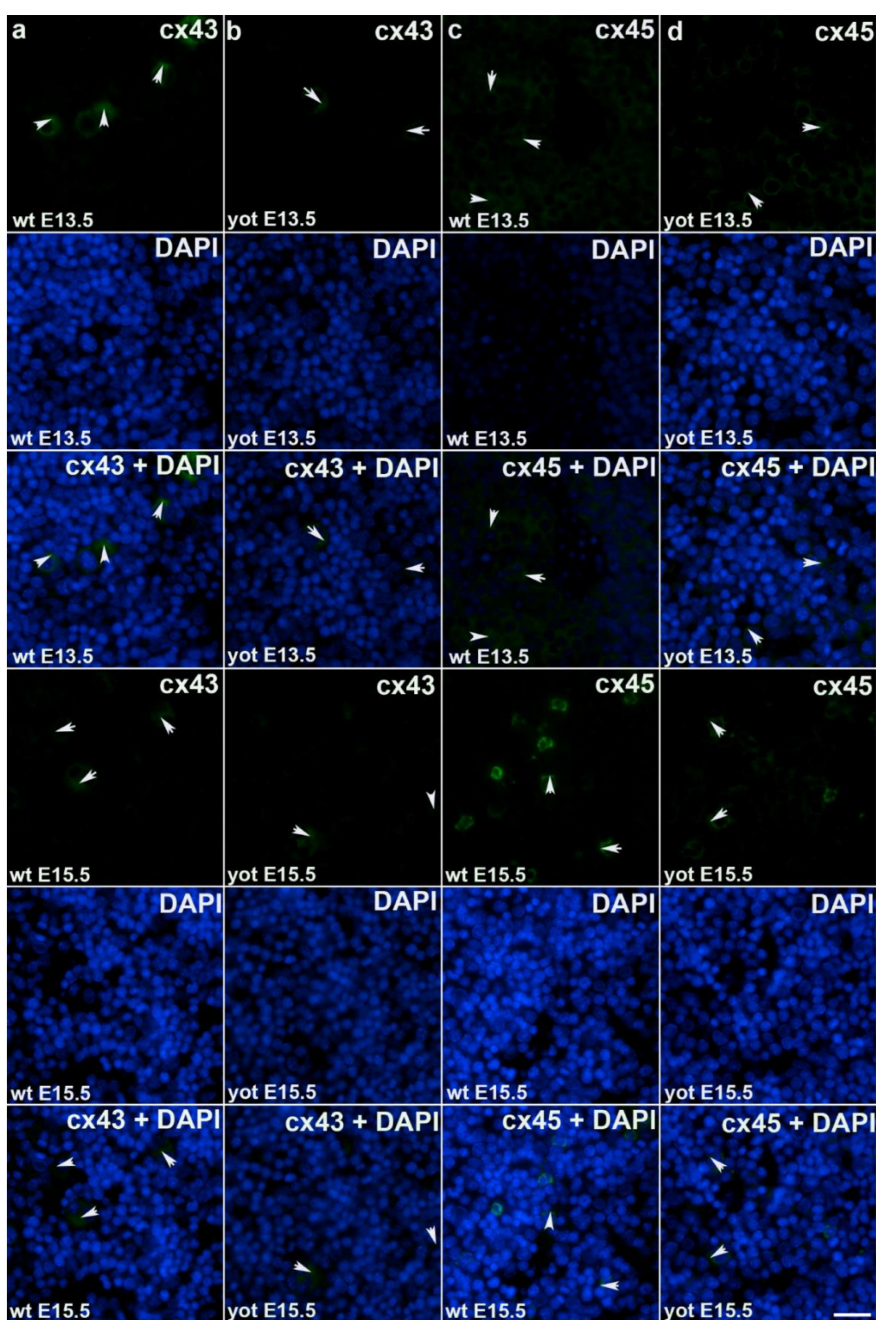
Figure 4. Immunofluorescence staining of connexins (Cxs): Cx43 and Cx45 in wild type and yotari mouse liver at gestation days E13.5 and E15.5. Immunoexpression of Cx43, 4 (cid:48) ,6-diamidino-2– phenylindole dihydrochloride (DAPI) staining and merged Cx43 and DAPI at E13.5 and E15.5 in wild type ( a ) and yotari ( b ). Immunoexpression of Cx45, DAPI staining and merged Cx45 and DAPI at E13.5 and E15.5 in wild type ( c ) and yotari ( d ). The scale bar is 8 µ m, refers to all